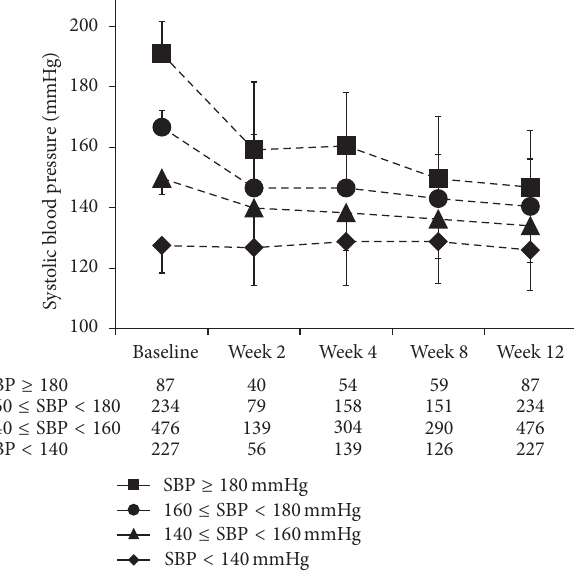
± standard deviation) from baseline to each observation time point during the 12-week treatment period in the effectiveness analysis population. The number of patients at each time point is indicated by the SBP levels under the